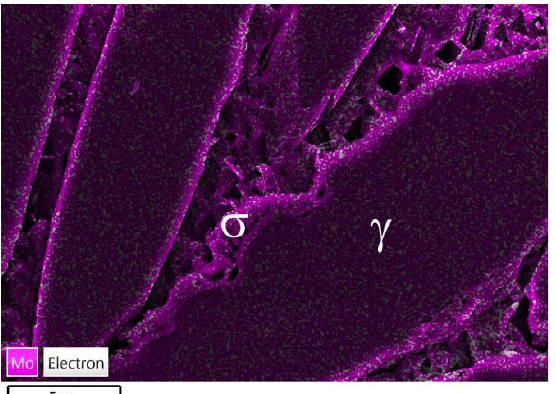
Figure 5. SEM image of microstructure of tested cast steel after holding at 750 °C for 1 h ( a ) and 3 h ( b ) (deep etching); ( c ) example of spectrum of precipitate occurring at  /  interface (Point 1, b ); (scanning microscope).